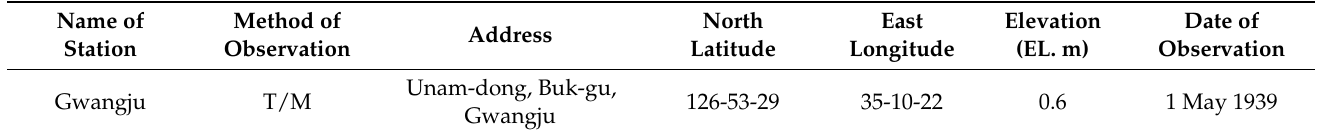
Table 2. The location of the observing station.